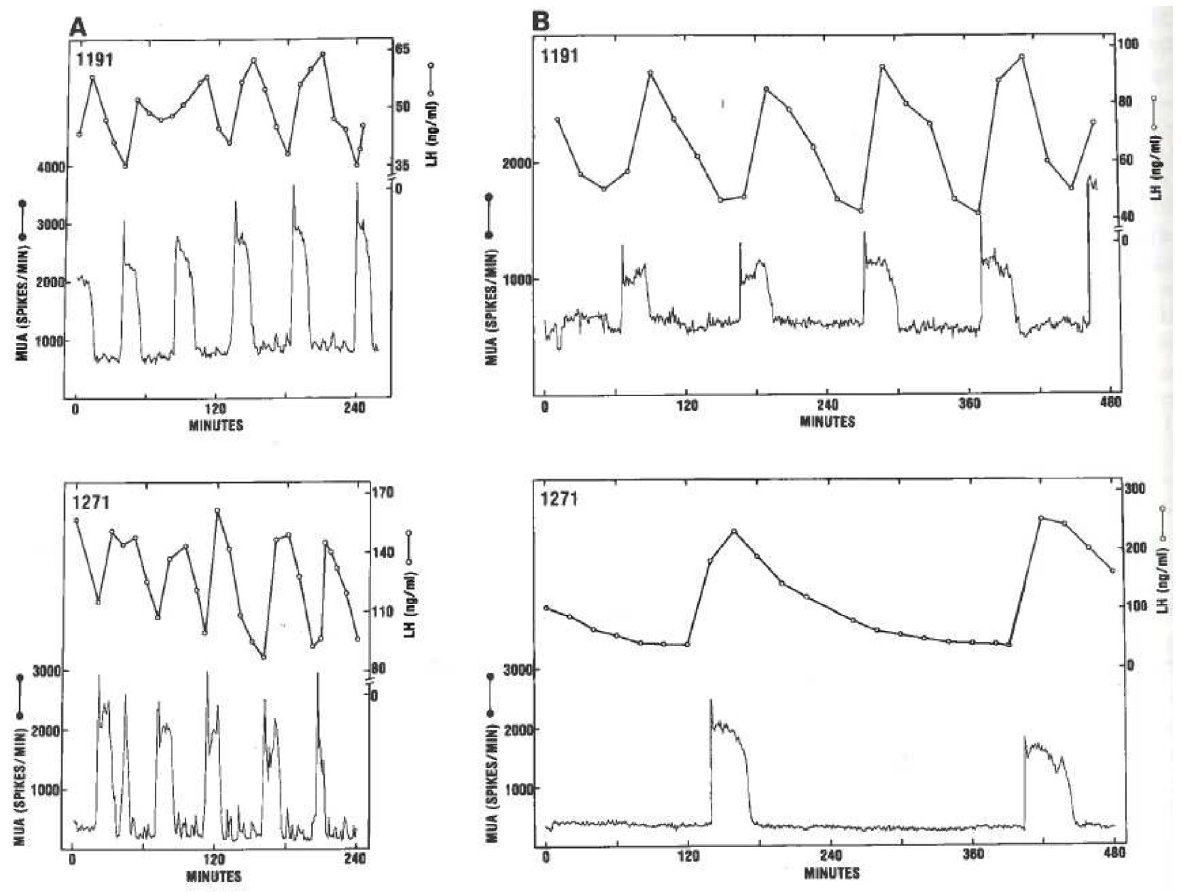
Figure 1. Pulsatile luteinizing hormone secretion is tightly correlated with electrophysiological activity in the monkey mediobasal hypothalamus. The relationship between luteinizing hormone (LH) “pulses”, observed in the peripheral circulation (open data points), and multiunit activity (MUA) (continuous trace) recorded in the mediobasal hypothalamus of two ovariectomized rhesus monkeys before (Panel A ) and after (Panel B ) anesthesia was induced with thiopental. Note the high-fidelity relationship between the two parameters regardless of frequency of pulsatile LH secretion. Reproduced from Wilson et al . 18 with permission of Karger Publishers. Copyright © (1984) Karger Publishers, Basel,